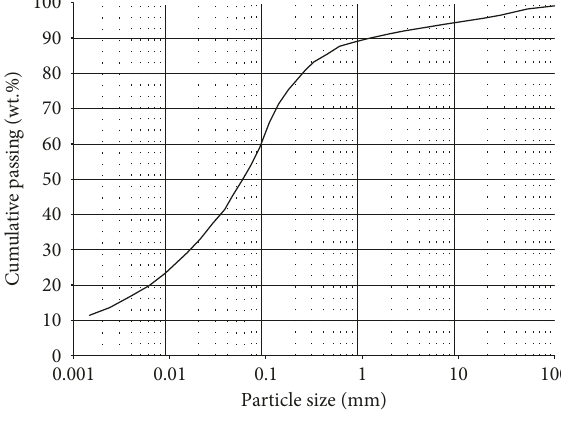
Figure 1: Particle size distribution of